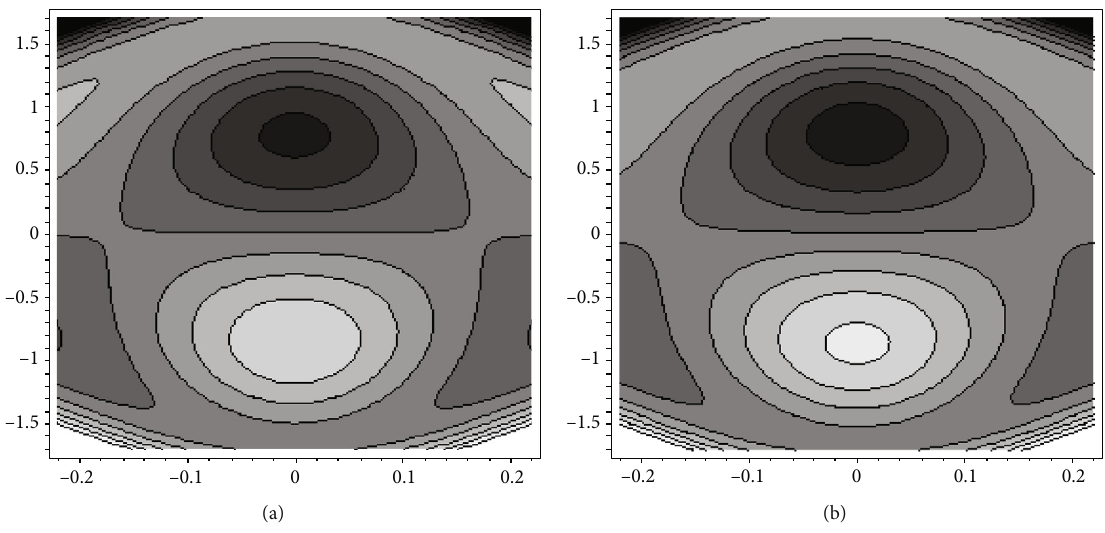
Figure 23: Stream lines for di ff erent values of We. The other parameters are n = − 0 : 8 , β = 4 , φ = 0 : 7 , y = 1 , and Q = 2 : 0